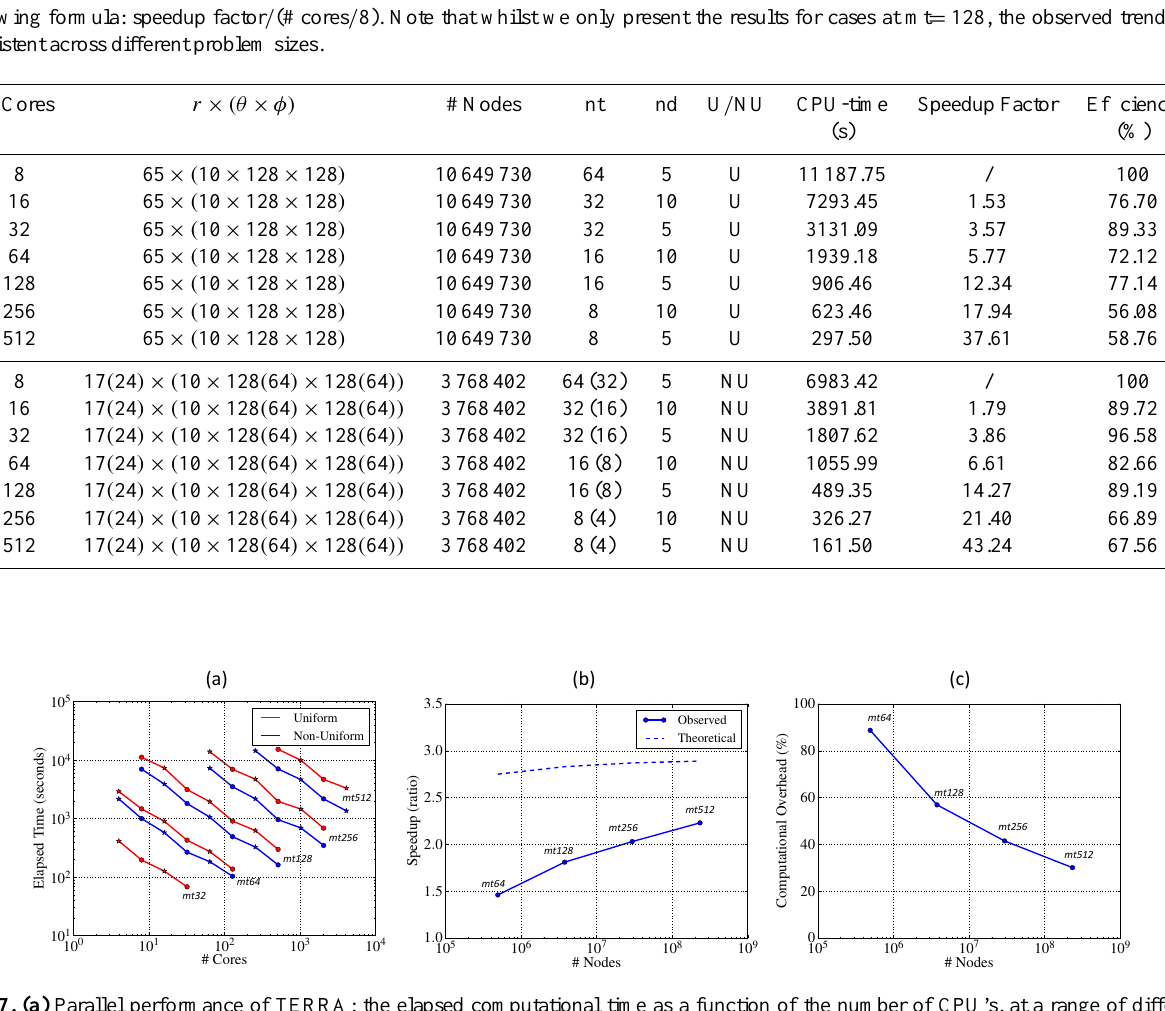
Fig. 7. (a) Parallel performance of TERRA; the elapsed computational time as a function of the number of CPU’s, at a range of different scales, utilizing different grid configurations – red and blue lines denote uniform and non-uniform configurations respectively. For non- uniform cases, mt denotes the lateral resolution in fine regions of the domain. We observe faster execution using a larger number of CPUs, as expected. Interestingly, variations are observed between different domain decompositions, with nd=5 cases (circles) being more efficient than nd=10 (stars). Due to a reduction in the number of nodes, the expended CPU-time decreases in moving from uniform to non-uniform configurations. Results for all configurations follow a similar pattern, illustrating that the non-uniform configurations integrate well